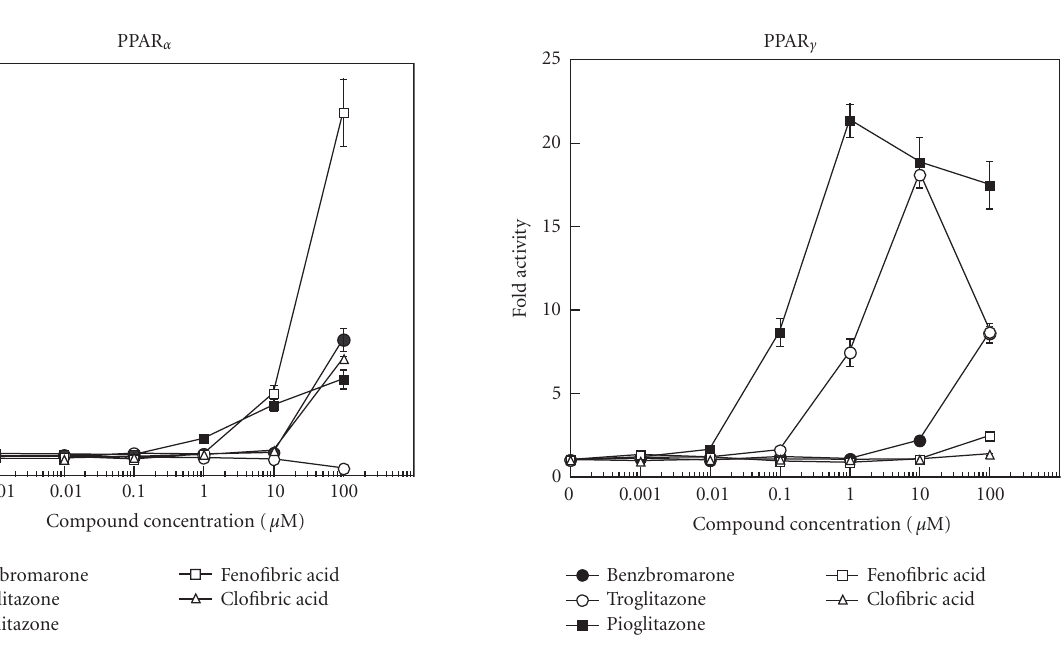
Figure 1: E ff ects of benzbromarone ( • ), troglitazone ( ◦ ), pioglita- zone ( (cid:2) ), fenofibric acid ( (cid:3) ), and clofibric acid ( Δ ) on PPAR α ac- tivation. Cells were transfected with the receptor plasmid for the chimera of the PPAR α ligand-binding domain and GAL4 DNA- binding domain, together with a reporter plasmid containing a GAL4-responsive promoter driving the expression of luciferase. Each point represents mean ± standard deviation (SD).